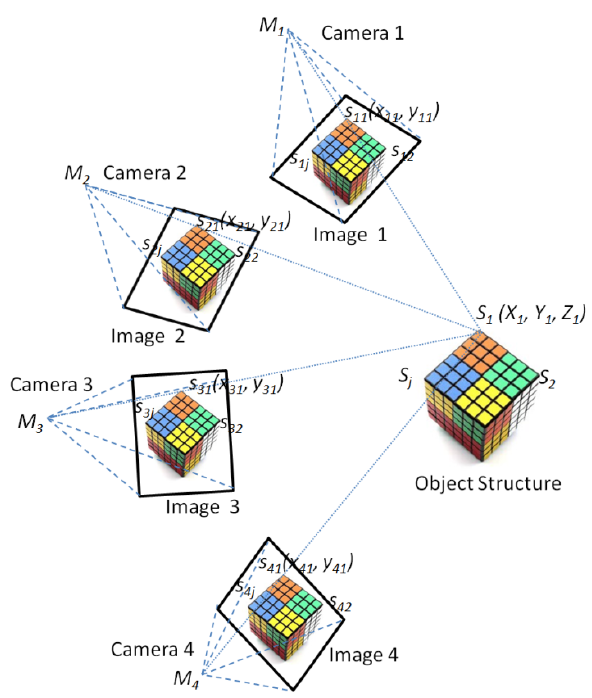
Figure 2. Methods for SfM for 3D model reconstruction.